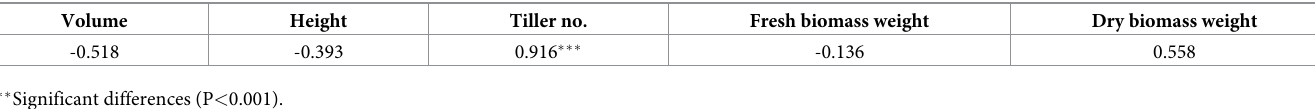
Table 1. Correlation between total CH 4 emissions and rice growth characteristics at harvesting